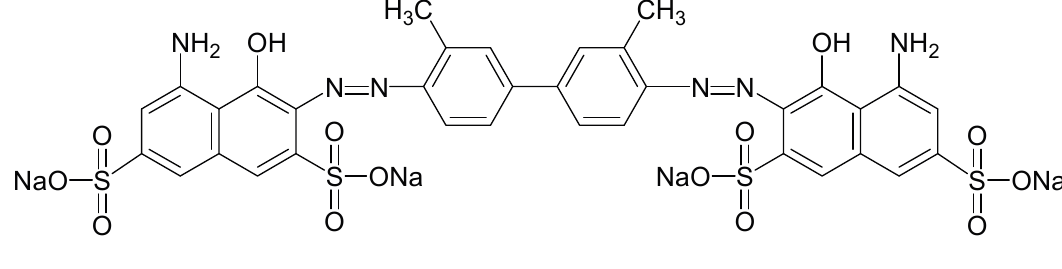
Figure 1. Structure of the benzidine-based azo dye Trypan